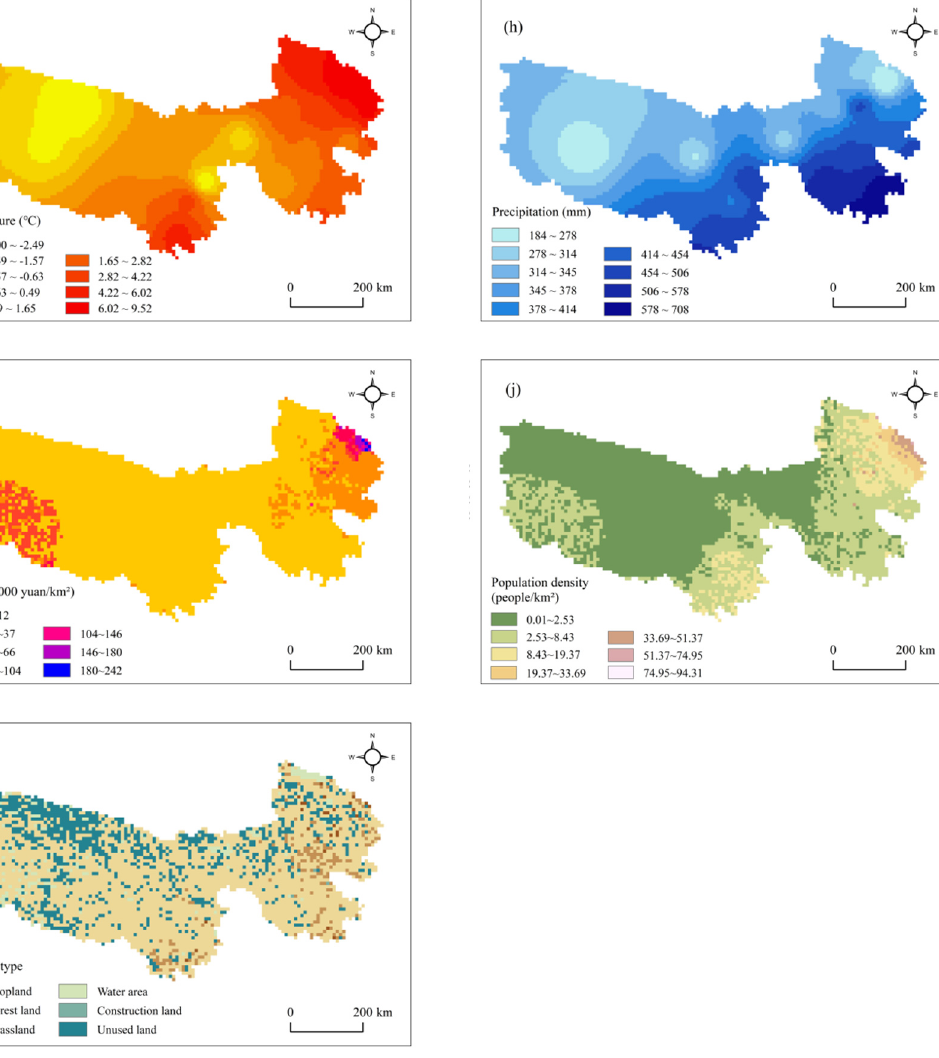
Figure 2. Classification of factors: ( a ) Slope; ( b ) Aspect; ( c ) Elevation; ( d ) Soil type; ( e ) Vegetation type; ( f ) Landform type; ( g ) Temperature; ( h ) Precipitation; ( i ) GDP; ( j ) Population density; ( k ) Land-use type.